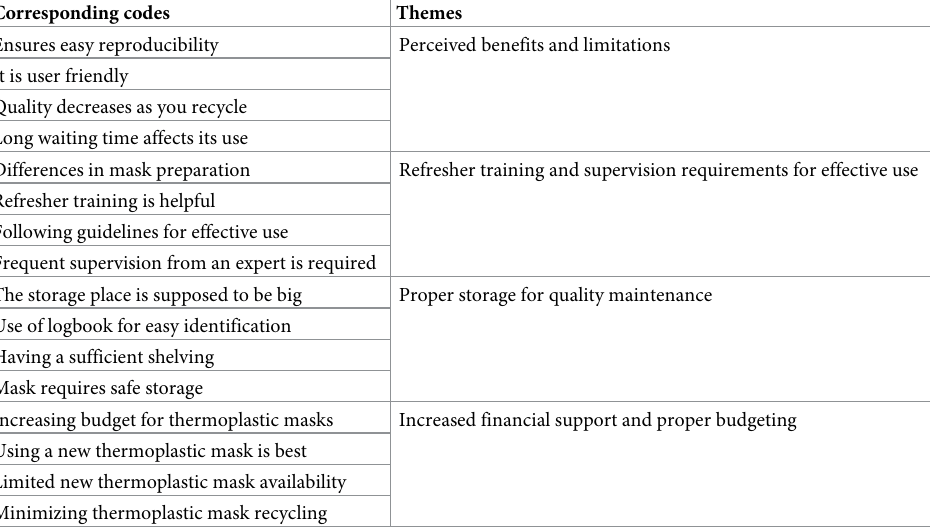
Table 1. Themes and corresponding codes for RTTs’ perceptions of thermoplastic mask